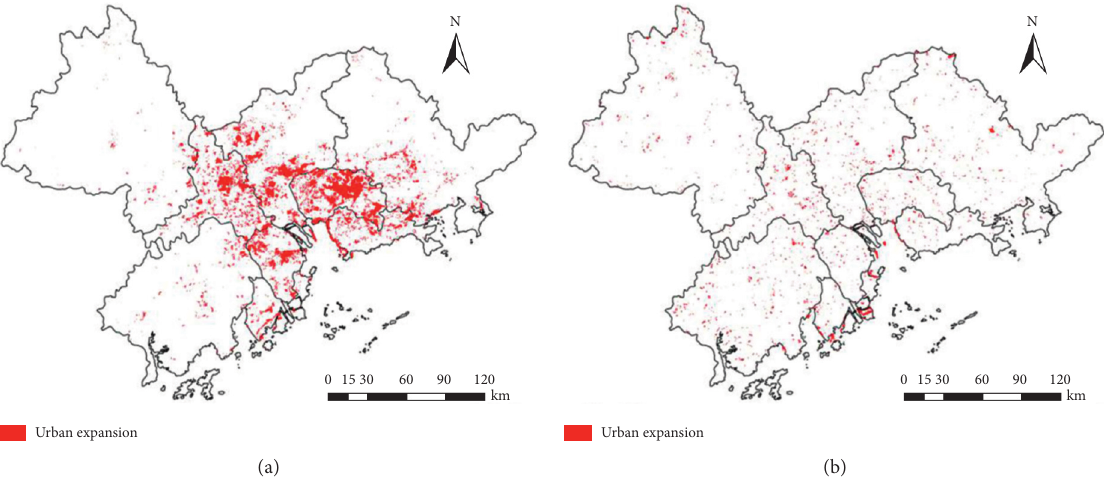
Figure 4: Spatial expansion characteristics of the Pearl River Delta urban agglomeration during (a) 2000–2008 and (b) 2008–2015. Table 1: Sources of urban expansion land in the Pearl River Delta urban agglomeration during 2000–2008 (km 2 ). Region Farmland Forest land Grassland Water Sum Guangzhou 400.42 121.67 545.85 Shenzhen